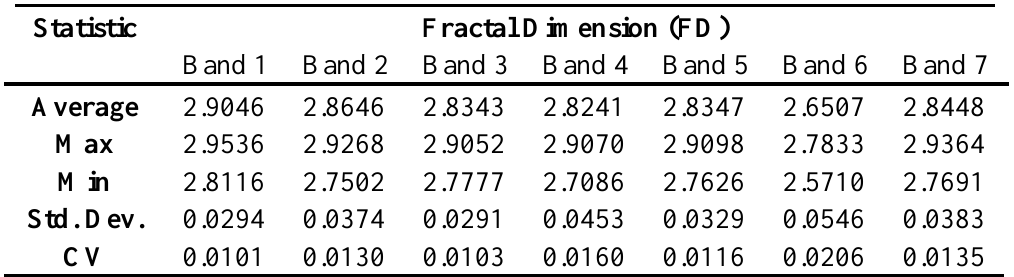
National Forest.